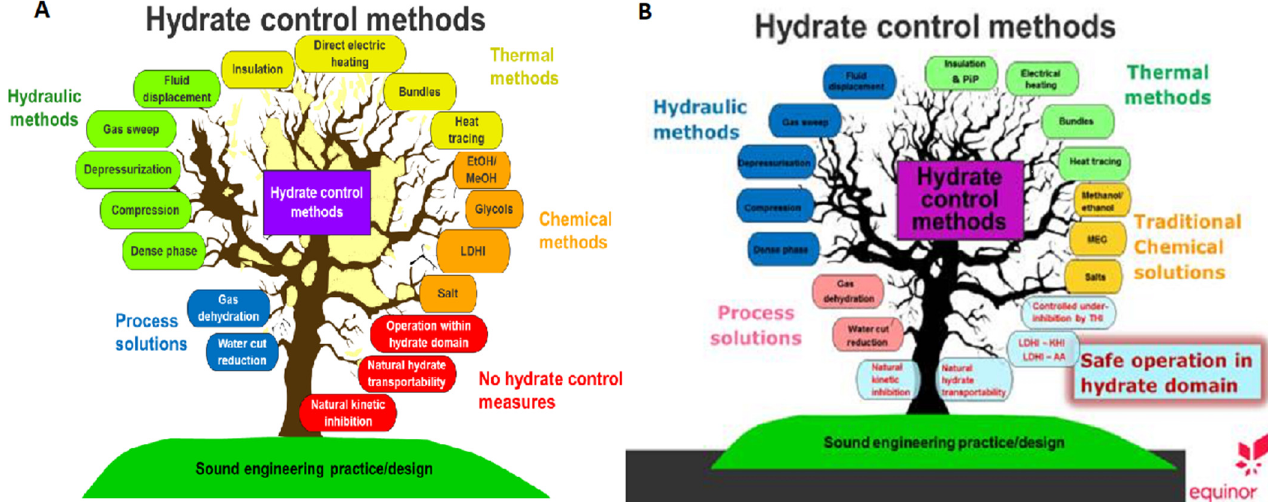
Figure 3. Equinor’s concept of hydrate flow assurance best practices in 2014 ( L ) and 2019 ( R ). Note the lower rightmost methods, are trending toward a “do nothing” strategy (Li, et al., [26]).